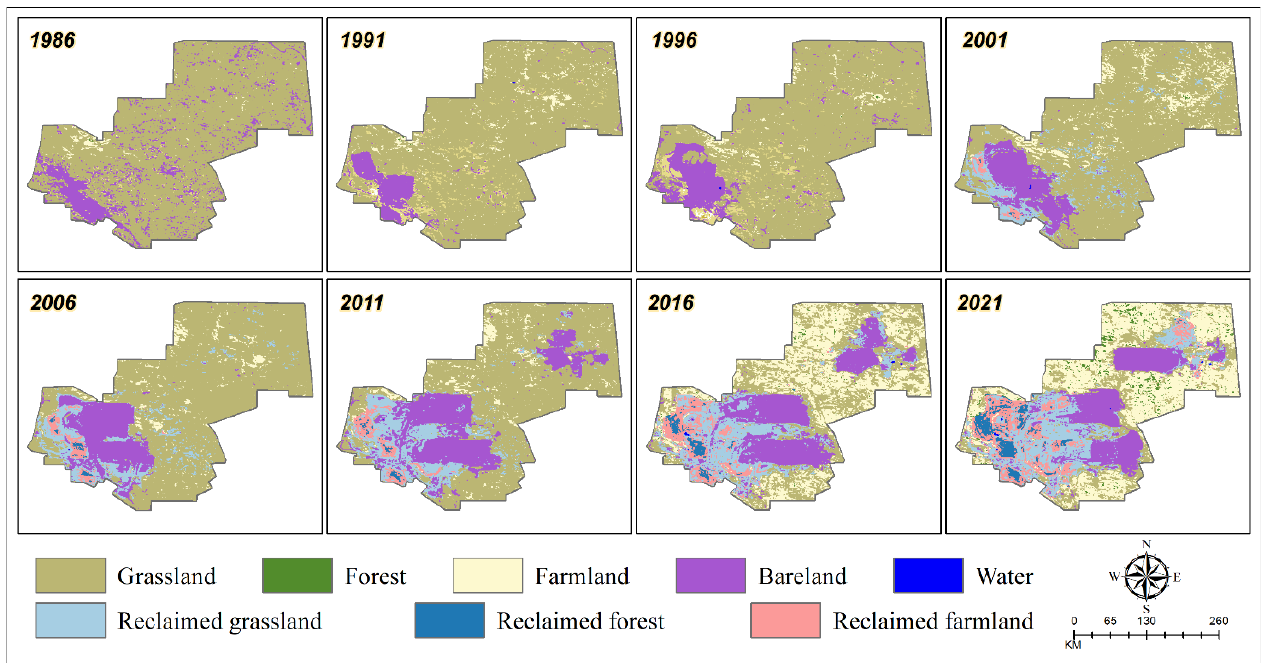
Figure 5. Land use classification at 5-year intervals during 1986 – 2021.